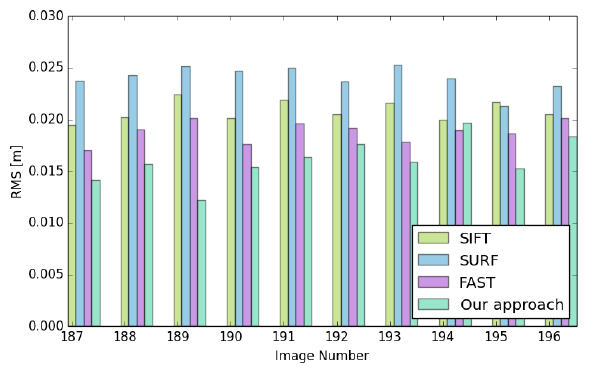
Figure 10. RMS error of the extracted feature points